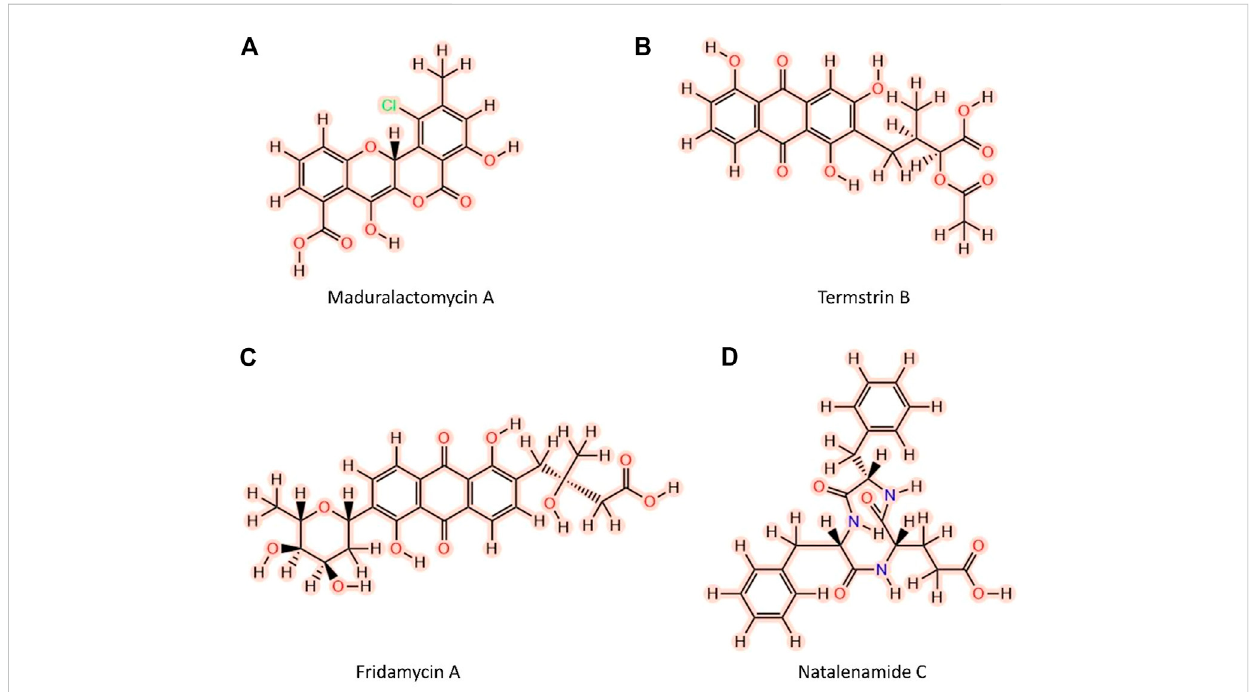
FIGURE 1 Two-dimensional structures of the top four Fungus-growing termite-derived NPs against MurF protein of A. baumannii shortlisted after molecular docking and computational Pharmacokinetics. (A) Maduralactomycin A, (B) Termstrin, (C) Fridamycin A, (D) Natalenamide C.